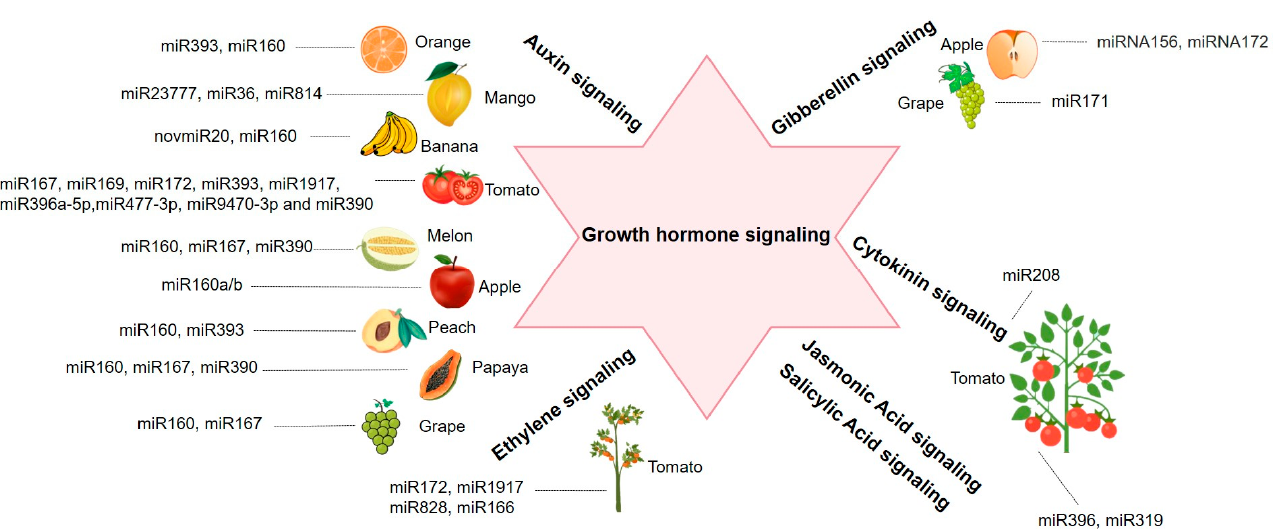
Figure 2. Role of conserved miRNAs in the well-designed regulation of growth hormone signaling in particular fruit